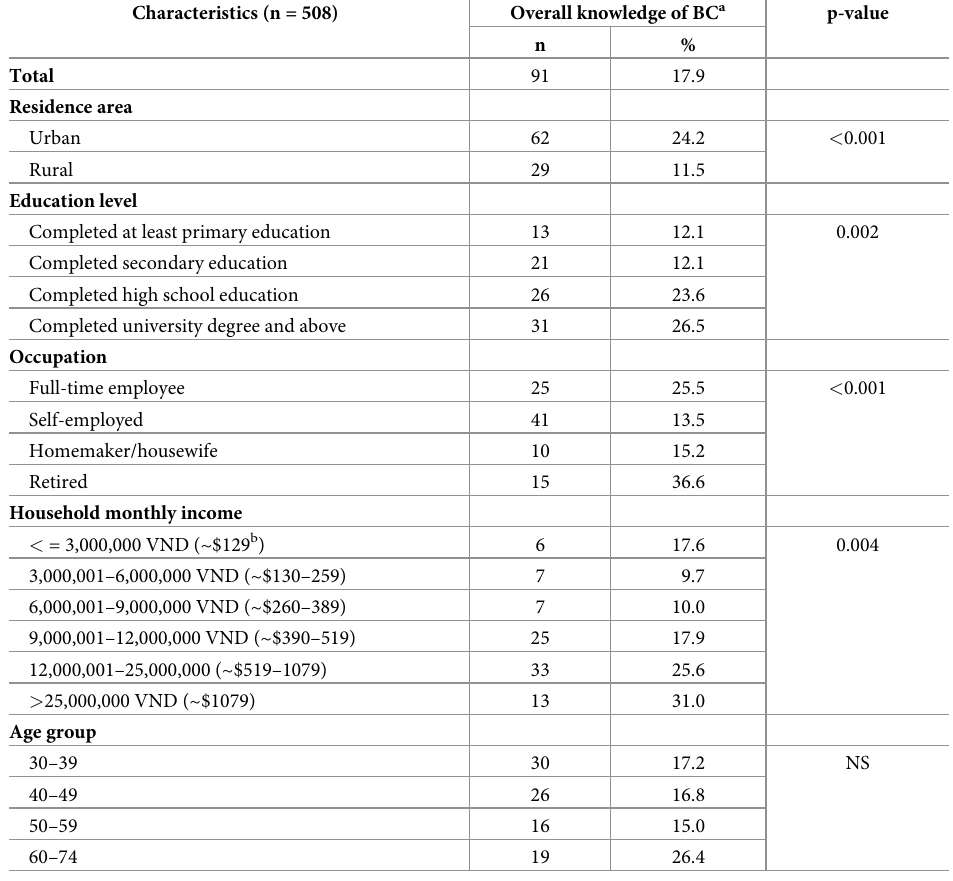
Table 2. Knowledge of breast cancer by sociodemographic